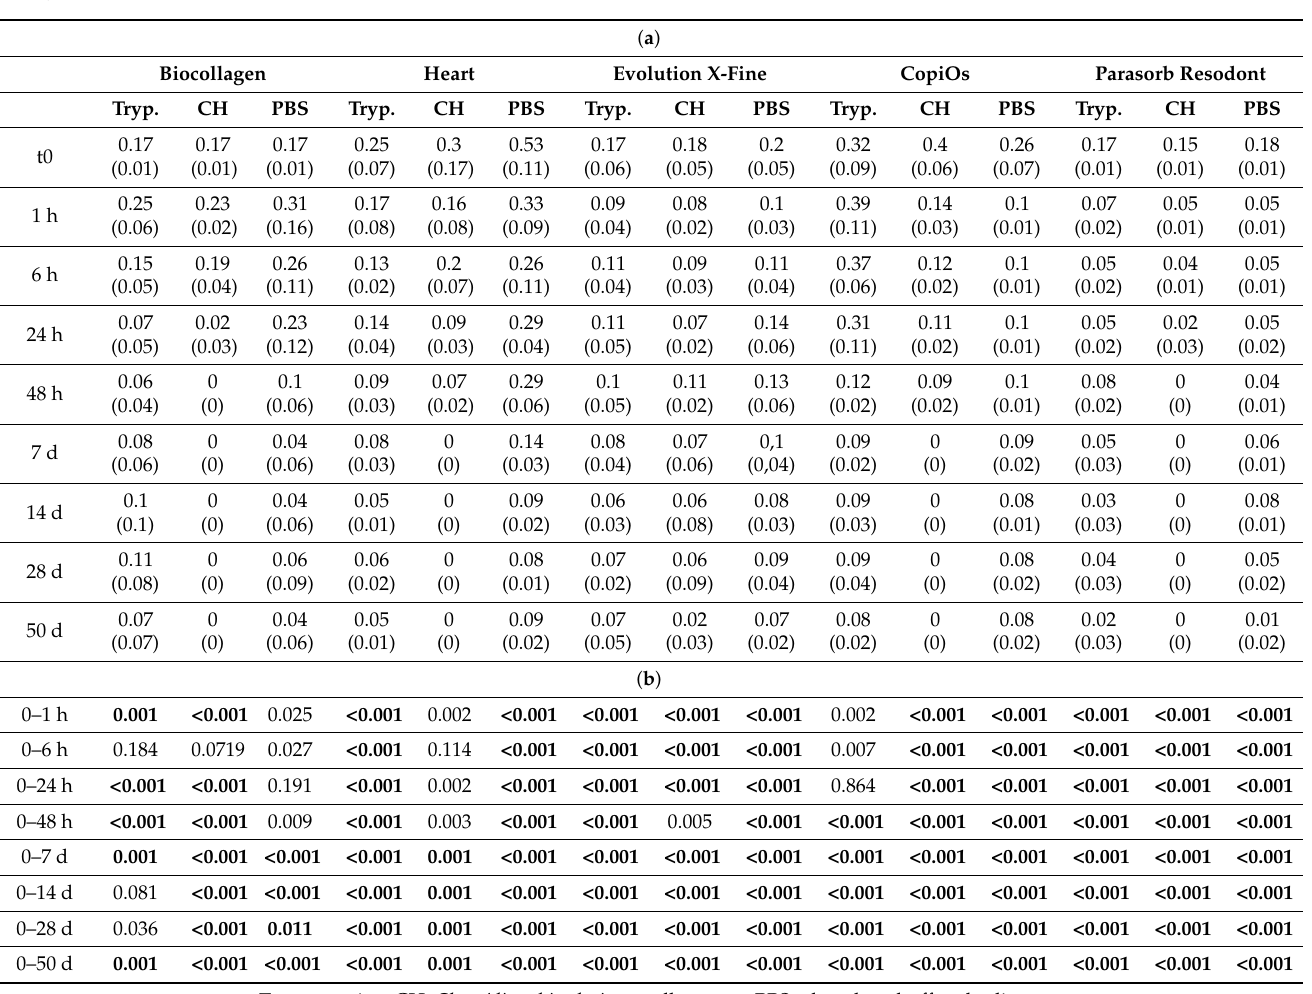
Table 2. ( a ) Thickness values (mm) of the five membranes (Biocollagen, Heart, Evolution X-fine, CopiOs and Parasorb Resodont) after being submitted to: PBS, trypsin and C. histolyticum , from 1 h to 50 d. Values are presented as means and standard deviations. ( b ) p values resulted from pairwise comparisons between membranes’ thicknesses before immersion (initial thickness or thickness at t0: Th0) and after the different immersion periods. Statistical significance was set at p <